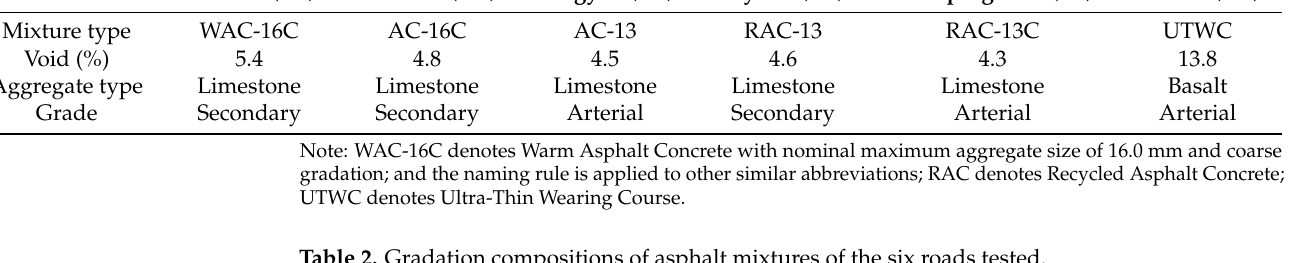
Table 2. Gradation compositions of asphalt mixtures of the six roads